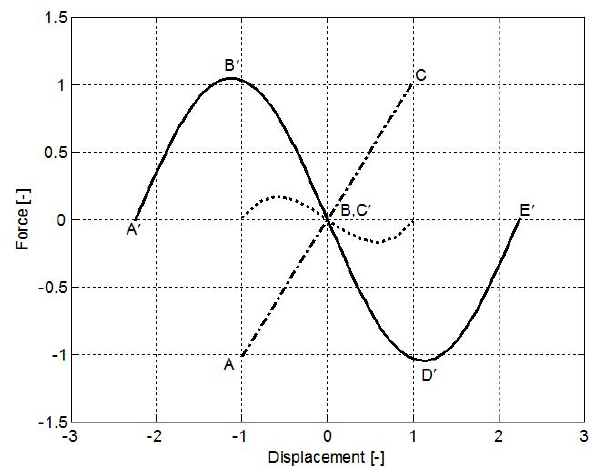
Figure 4. Conceptual dimensionless force-displacement behavior of statically balanced compliant grasper (SBCG) for the case of bi- stable behavior. Force-displacement behaviors accomplished by us- ing sti ff er balancer; sti ff ness of the static balancers may be adjusted by varying thicknesses and initial